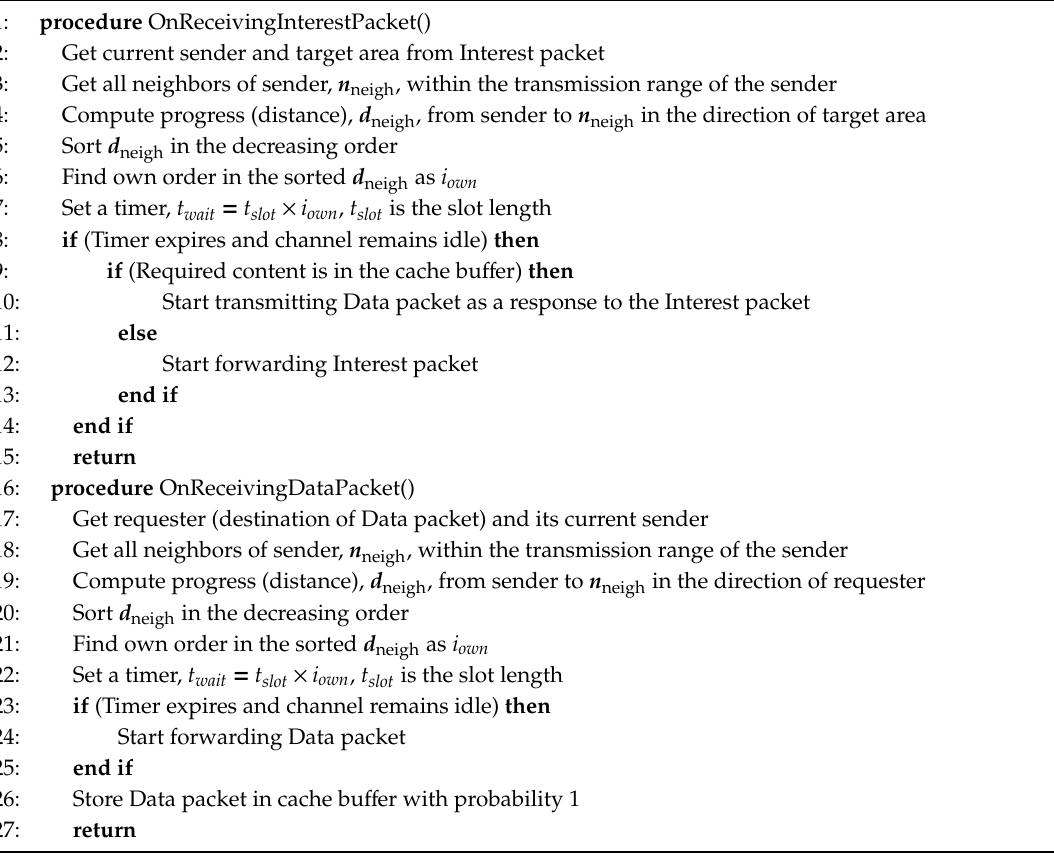
Figure 2. CV method. Algorithm 1 Processing Interest and Data packets in the CV method